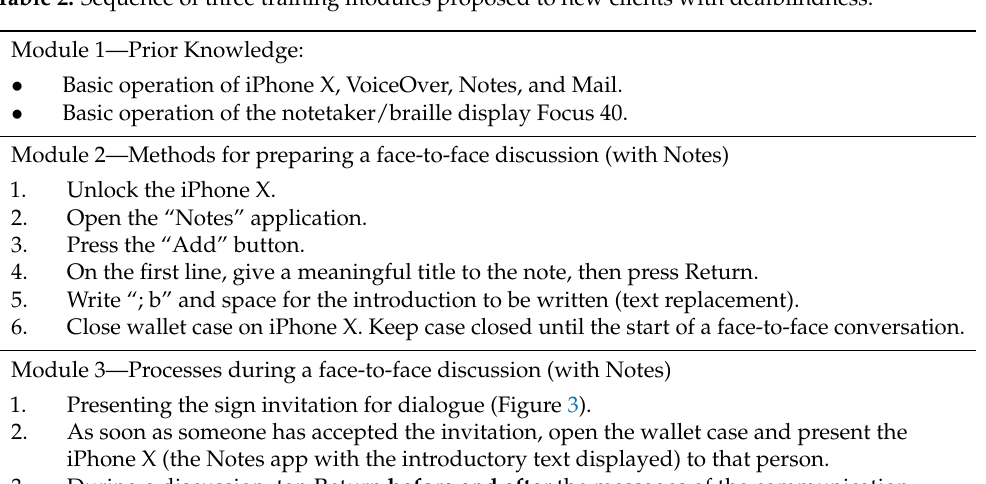
Table 2. Sequence of three training modules proposed to new clients with deafblindness.